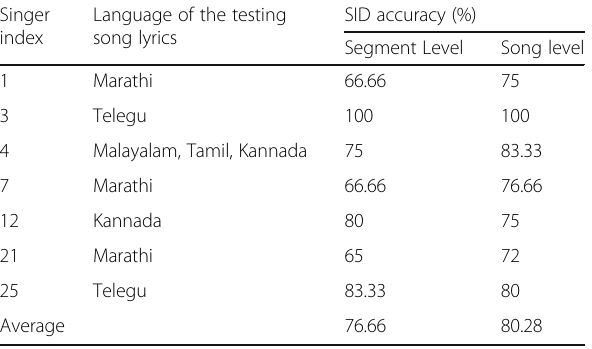
Table 3 Effect of multi-language songs on SID performance Singer Language of the testing index song lyrics